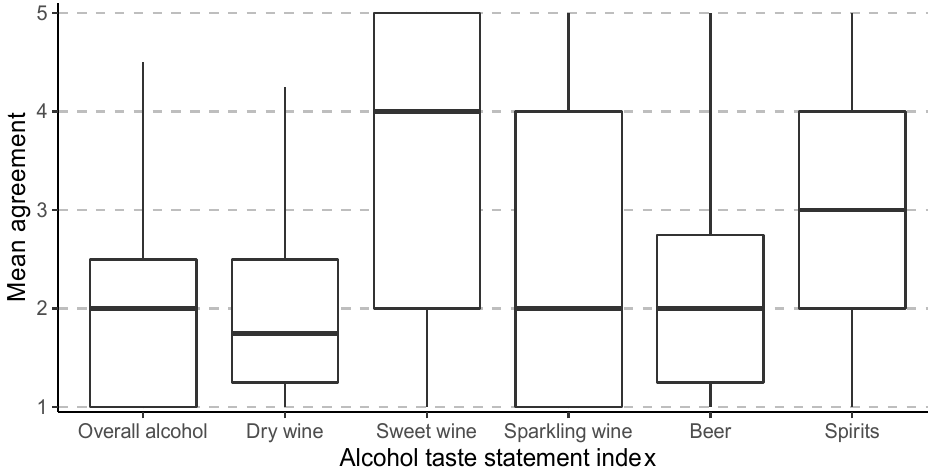
Figure 1. Boxplots of Likert scores for the alcohol taste indices ( n =